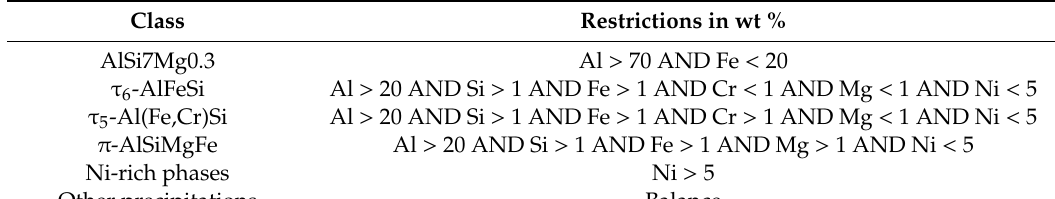
Table 5. Rule file for the classification of precipitations in the AlSi7Mg0.3.